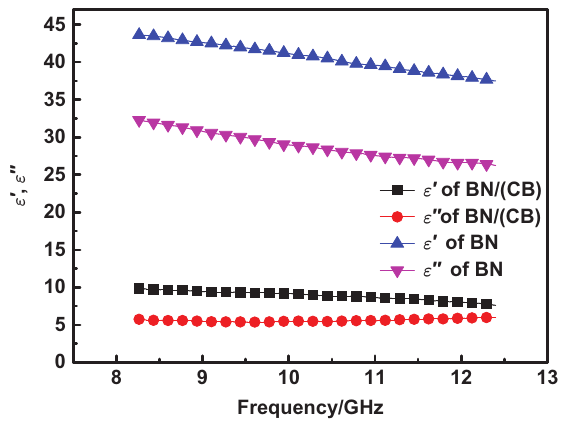
Figure 6: Characteristic impedance of the CB particles and the BN(CB) particles at different